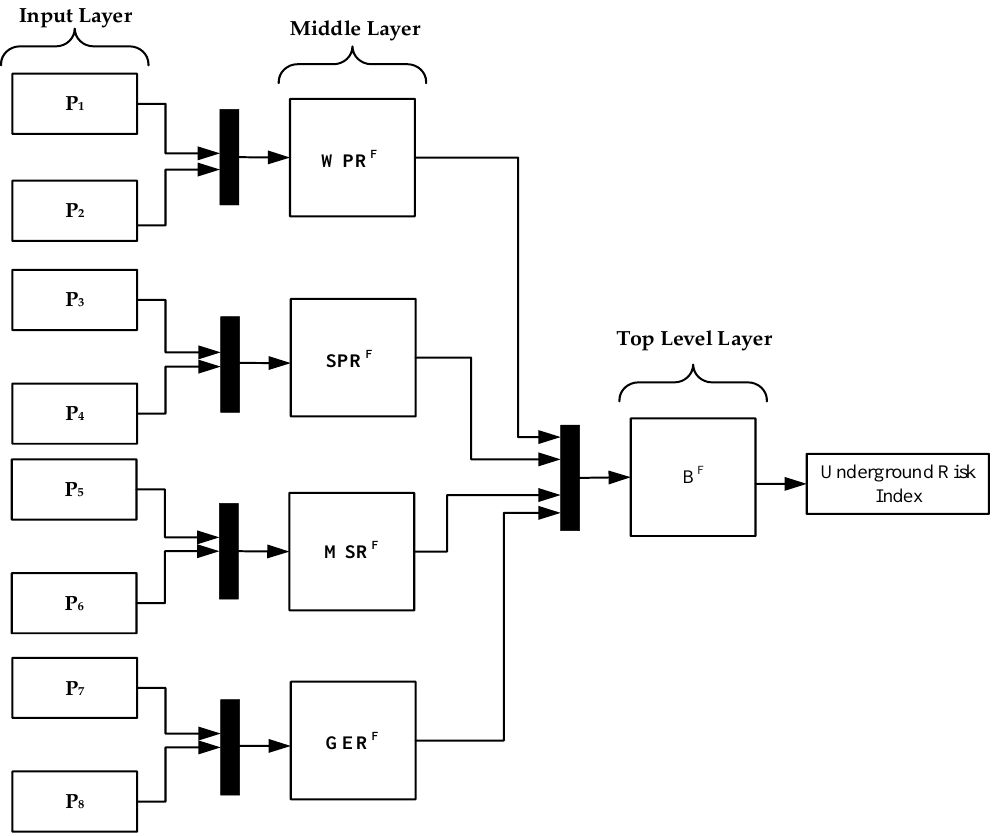
Figure 2. Proposed simplified hierarchical fuzzy logic (SHFL) model.